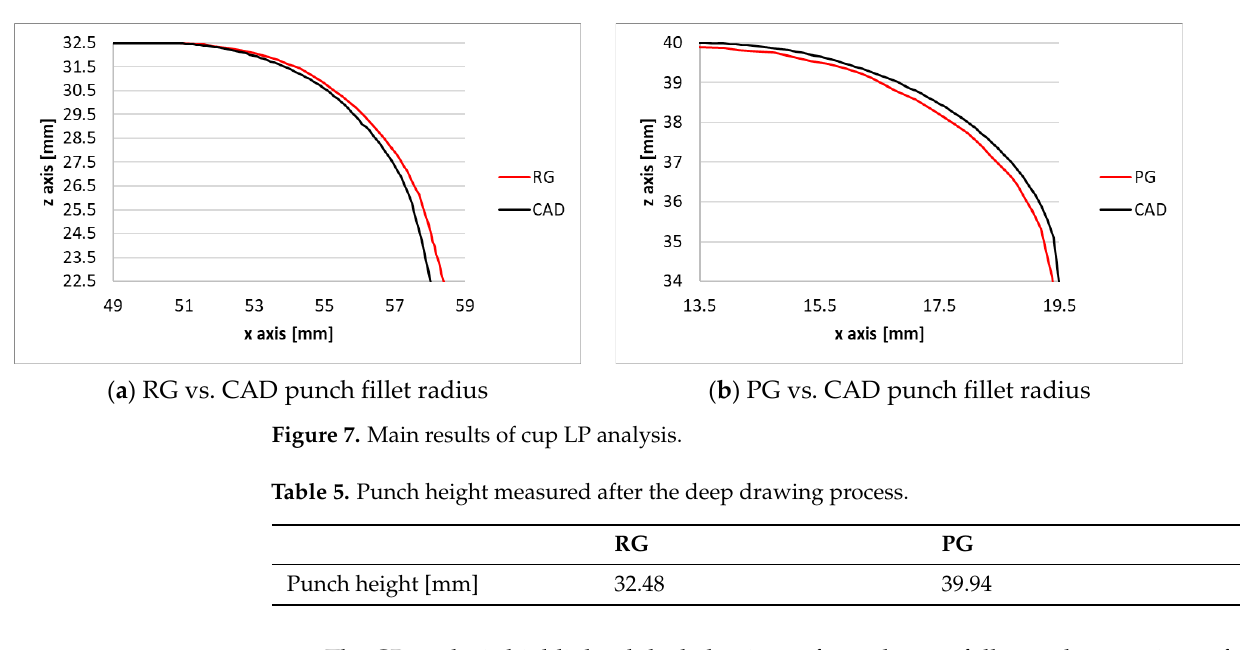
( b ) Cup CP analysis of PG at 6 mm from the top Figure 6. Main results of cup CP analysis. Table 4. Main results of cup CP analysis.